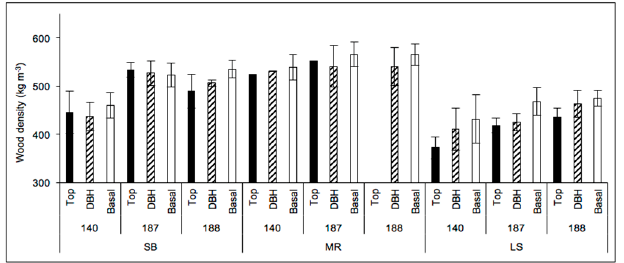
Figure 9. Wood densities (kg m -3 ) at various tree positions of three poplar clones (140, 187, and 188) from stands located in the Piedmont (SB), the upper Blue Ridge Mountains (LS), and the lower Blue Ridge Mountains (MR).